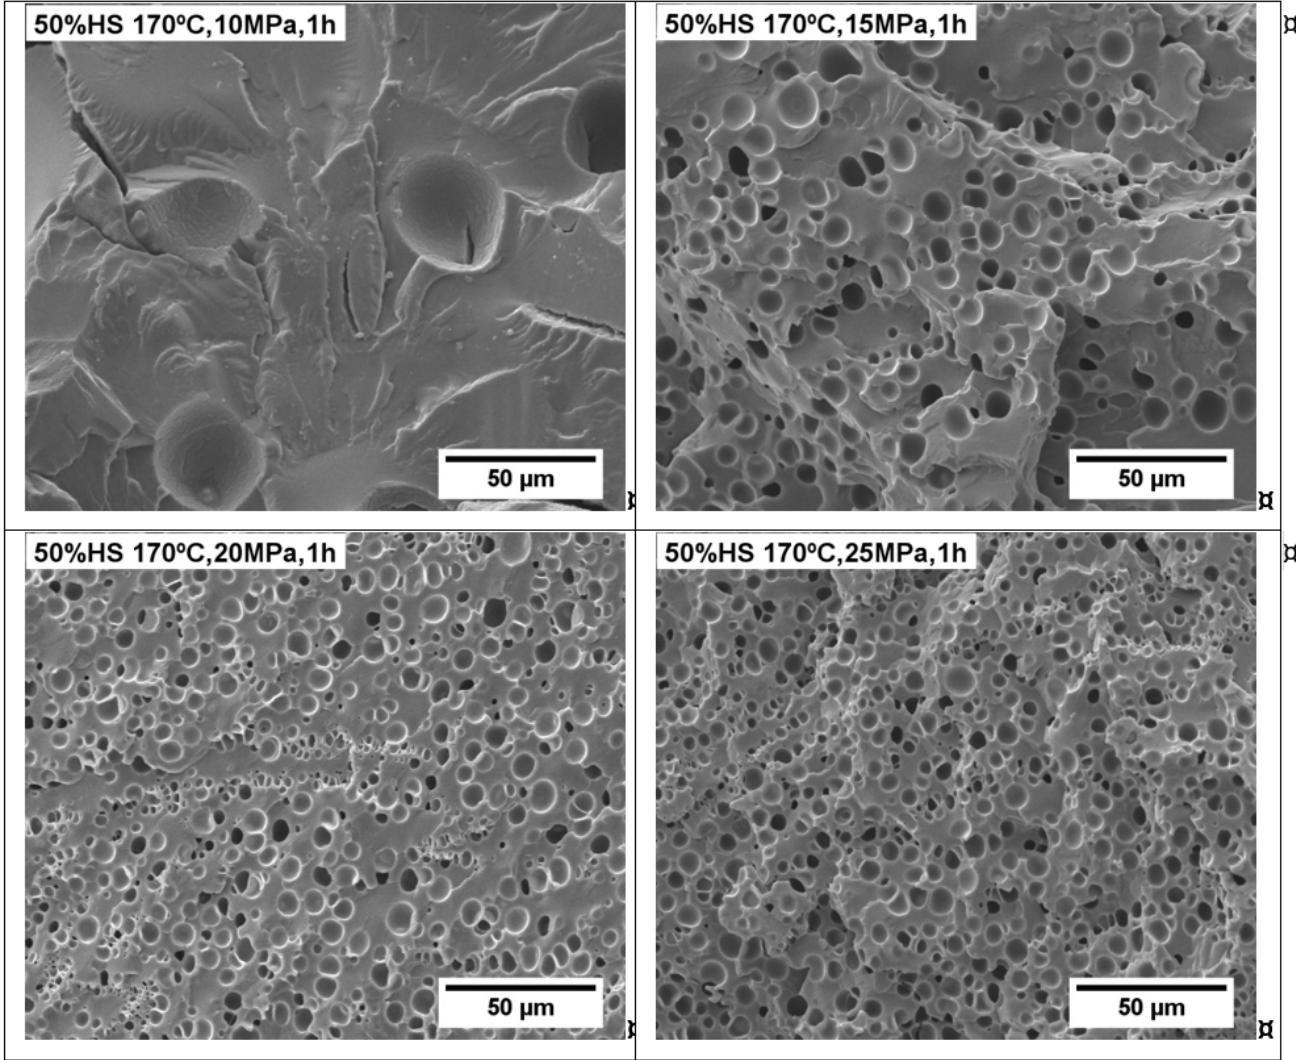
Figure 7. SEM micrographs of TPU 50%HS foamed by one-step between 10 and 25 MPa, 170 ° C, and 1 h.